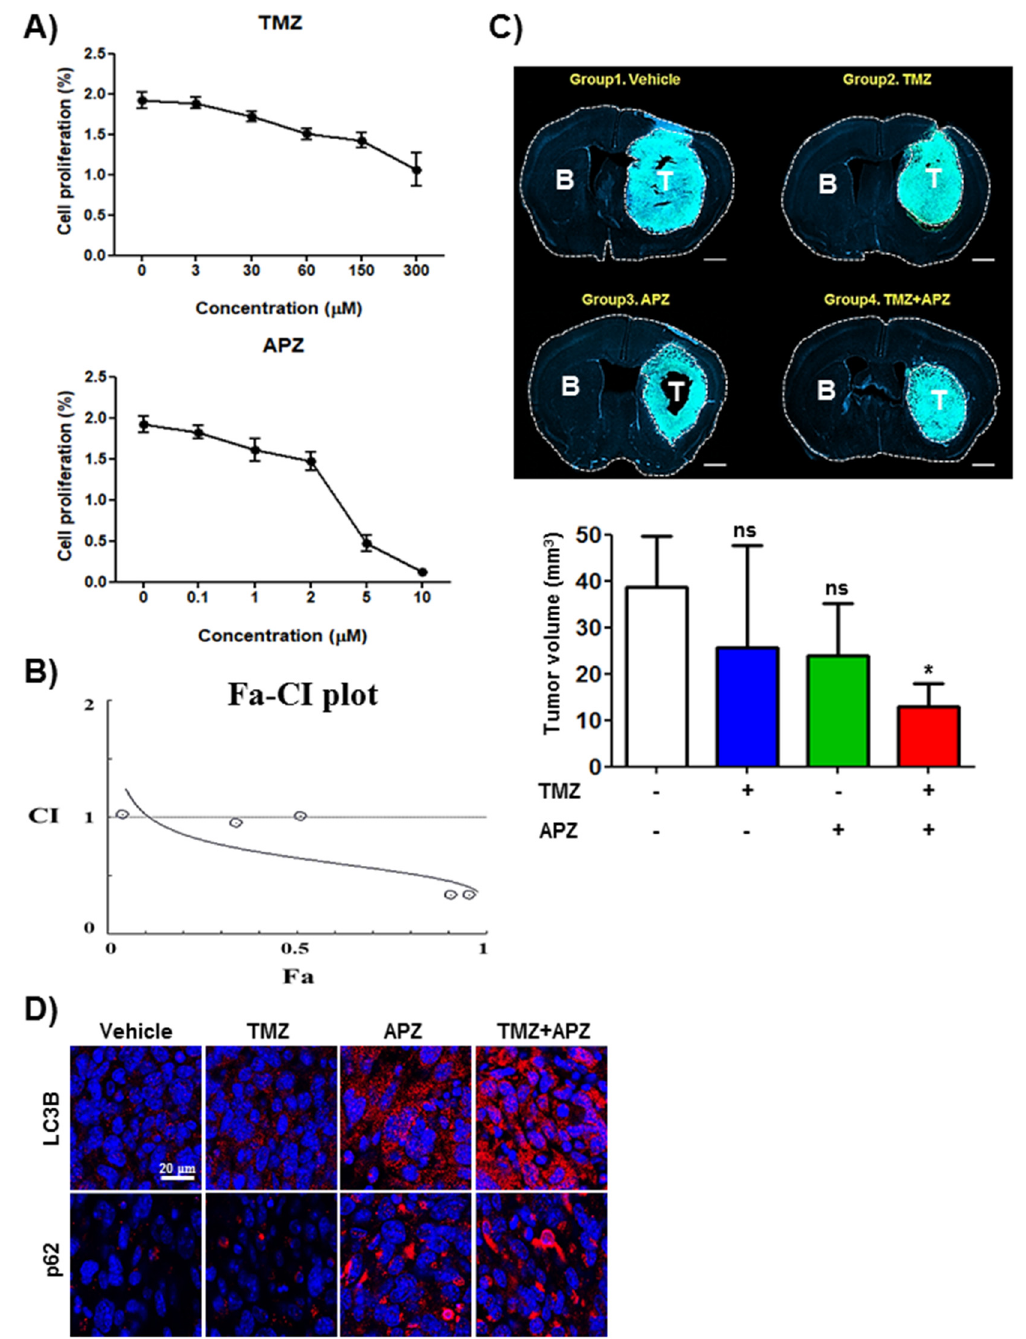
Figure 3. APZ shows the outstanding combinational effects with temozolomide (TMZ) in vitro and in vivo. ( A ) Effect on TMZ or APZ on the proliferation of GFP-GL261 in vitro. All cells were treated with TMZ or APZ for 48 h as indicated and cell growth was measured using an MTT calorimetric assay. N = 3 means ± SE. ( B ) Combination index plot for TMZ with APZ in GFP-GL261. Combination index (CI) plotted against fractions affected (Fa) analyzed using COMPUSYN software, which is a general software for dose and effect Pharmaco-Dynamics (PD) and Bio-Dynamics (BD). ( C ) Synergic effects of TMZ and APZ on tumor growth in vivo. Mice bearing glioma consisting of GFP-GL-261 cells in brain were treated with vehicle, TMZ (25 mg/kg), APZ (10 mg/kg), and combinational treatment of TMZ (25 mg/kg) with APZ (10 mg/kg) every other day (B: Brain region, T: Tumor region). Tumor volume of the mice in each group ( n = 4) were measured over 18 days. * p < 0.05. ( D ) Representative images showed the immunofluorescence staining of p62 and LC3B (red) in brain glioma sections. Nuclei were stained with DAPI (blue). Scale bar, 20 μ m.